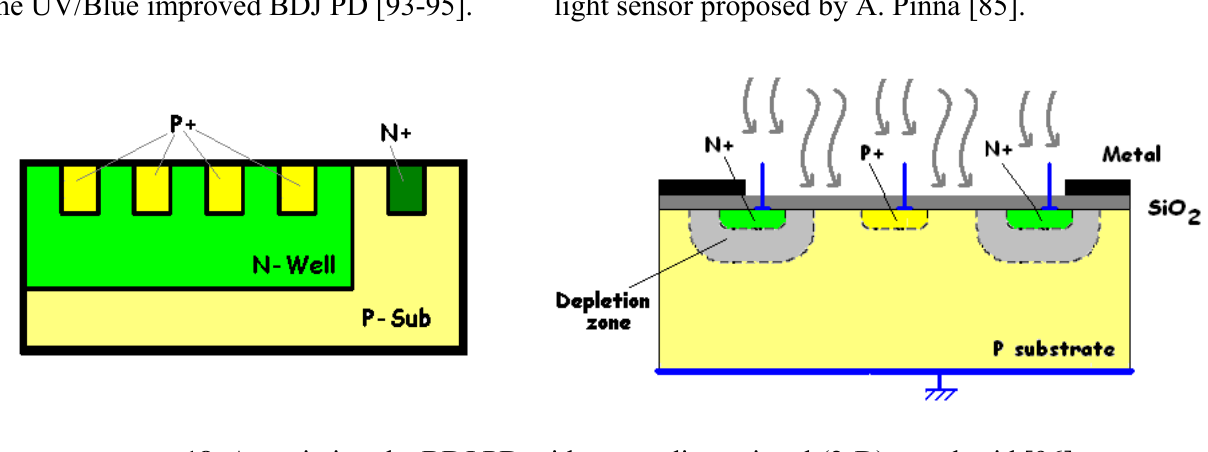
Figure 16. Simplified cross-section of the UV/Blue improved BDJ PD [93-95].